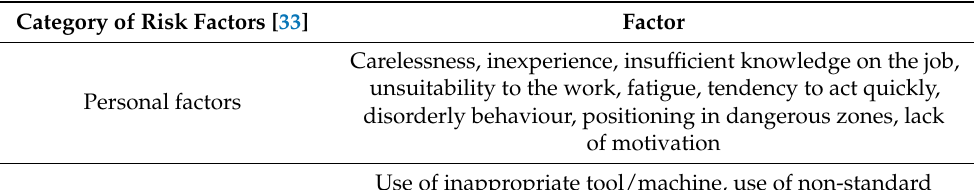
Table 1. Risk factors used for qualitative analysis of H&S related